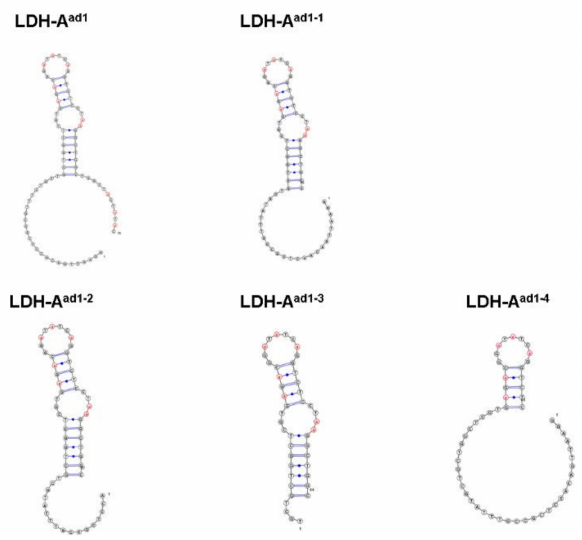
Figure A8. Predicted secondary structures of LDH–Aad1 and truncated aptamers (Aad1 − 1, Aad1 − 2, Aad1 − 3, and A ad1 − 4 ) using the VALFold software and the general DNA parameters [37,38]. The letter “a” indicates A ad .